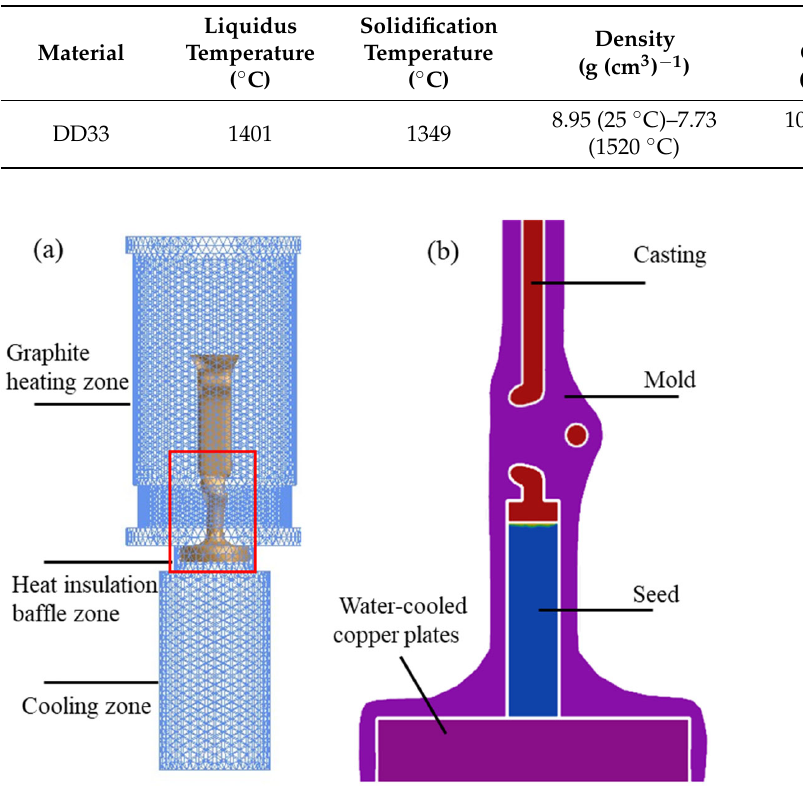
Table 2. Model parameters for solidification modeling.